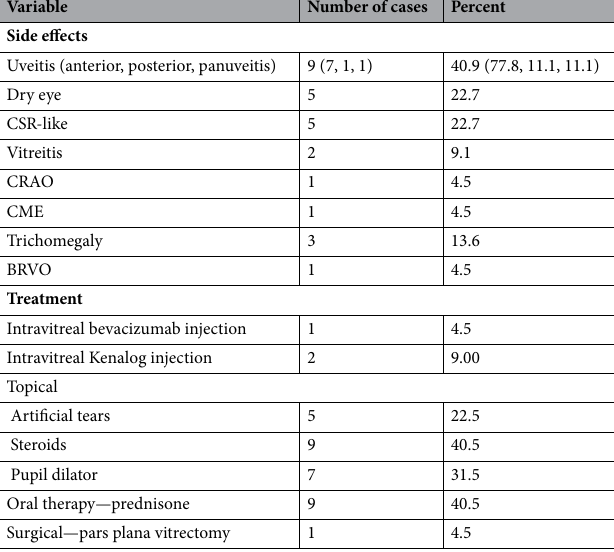
Table 3. Ocular side effects and treatment. CSR, central serous retinopathy; CRAO, central retinal artery occlusion; CME, cystoid macular edema; BRVO, branch retinal vein occlusion.